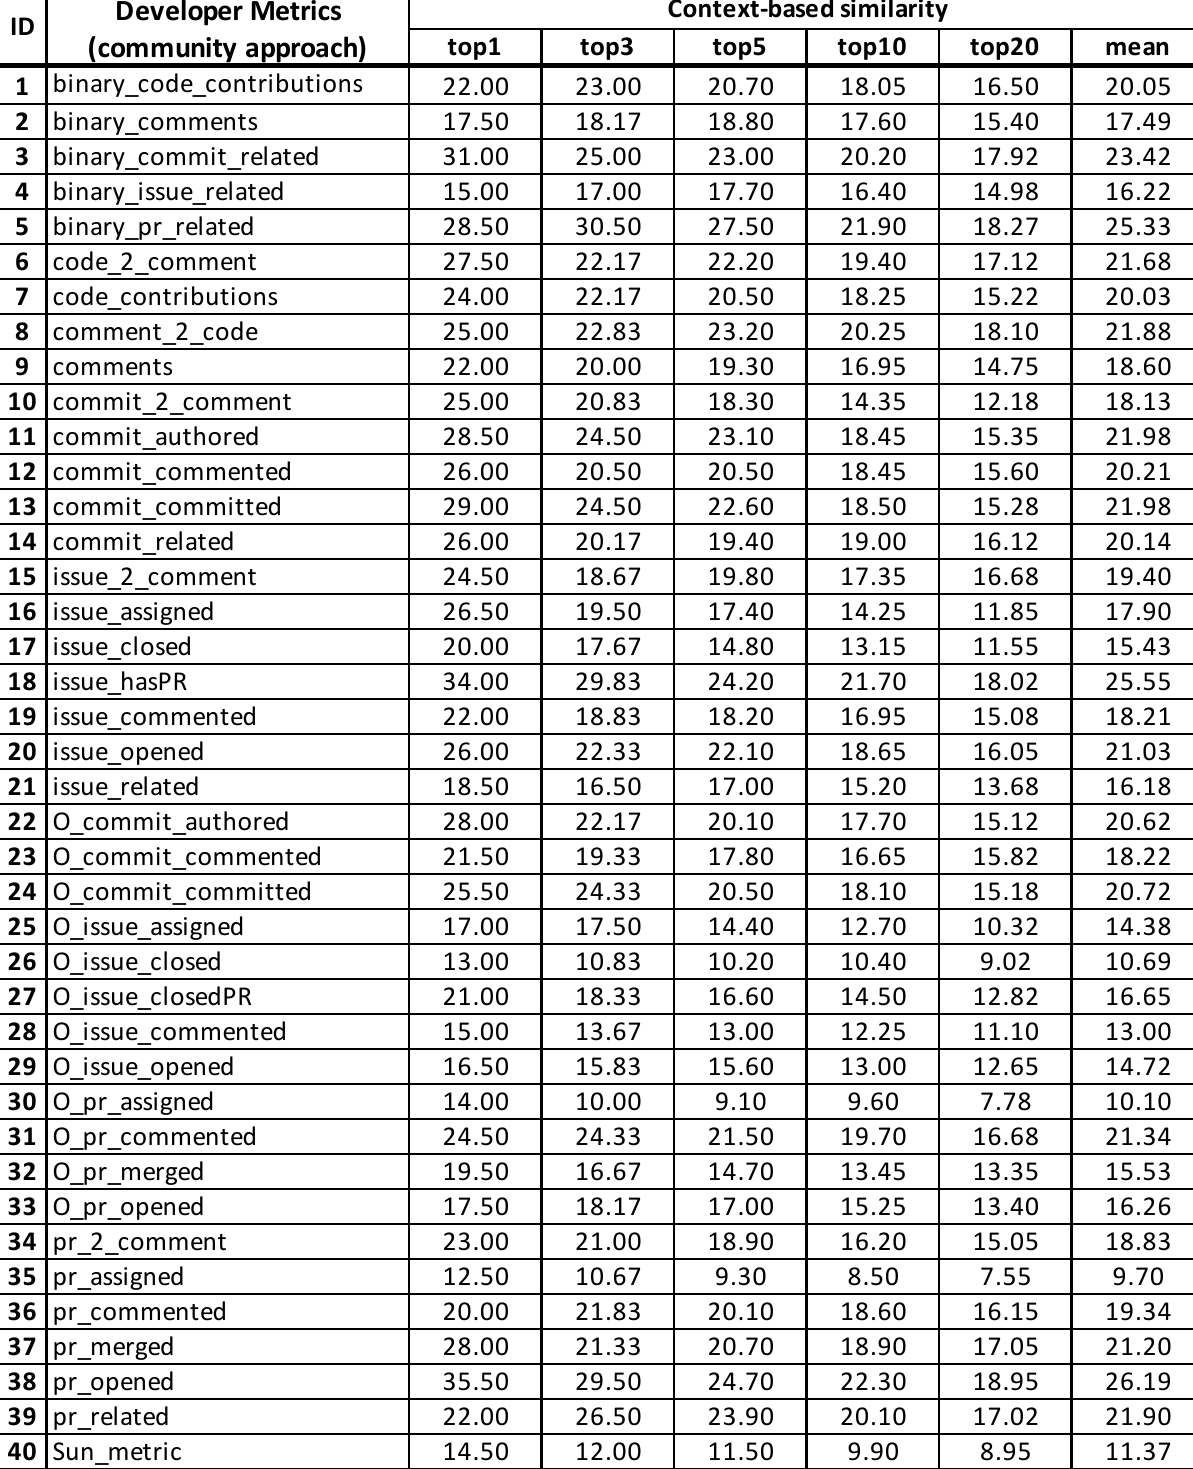
Table A2. All developer metrics all scores to evaluate with the community approach